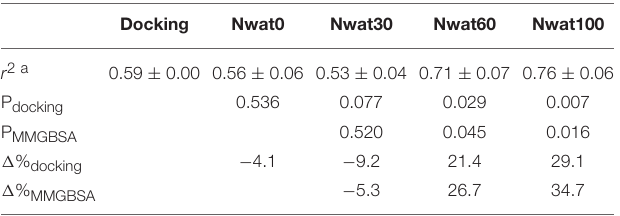
TABLE 2 | ROC AUC values obtained at different scoring conditions for the Rac1-Tiam1 system. Docking